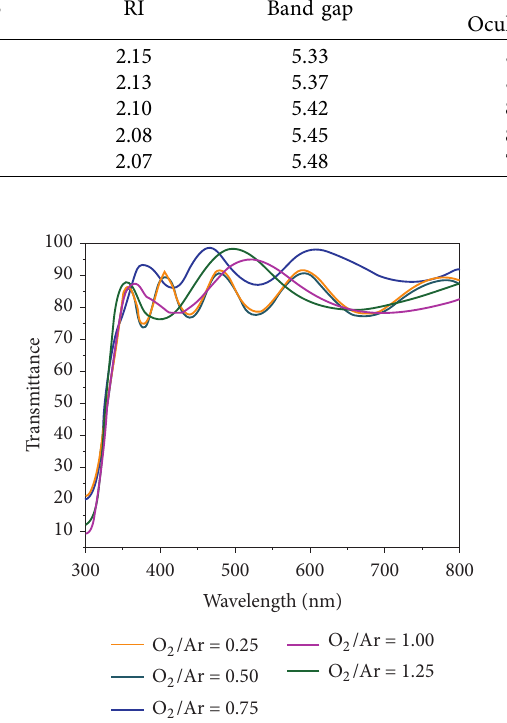
2 at various ratios of oxygen/